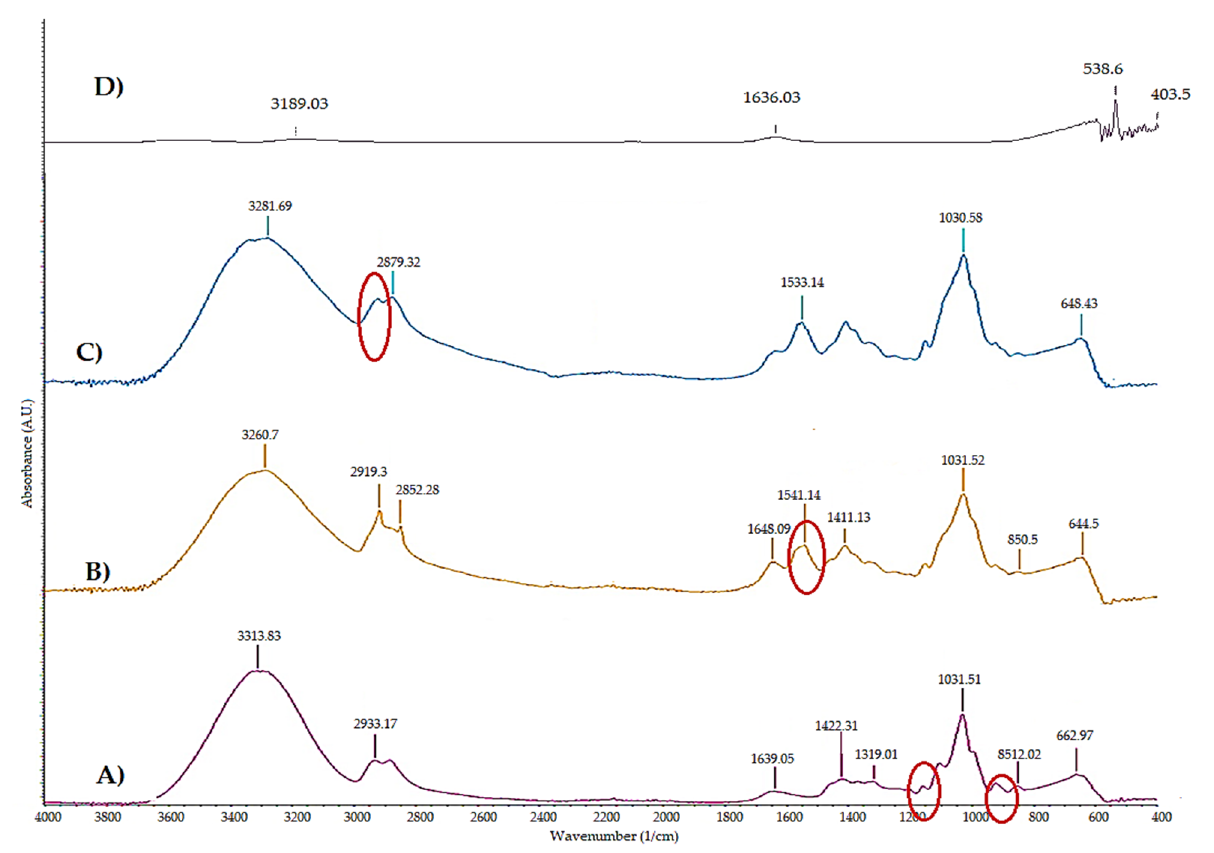
Figure 4. Films’ spectrogram. ( A ) Corn cob cellulose (C), ( B ) Cellulose–Chitosan (C-CH), ( C ) Cellulose–Cellulose nanocrystals–Chitosan (C-NC-CH) and ( D ) Chitosan (CH).